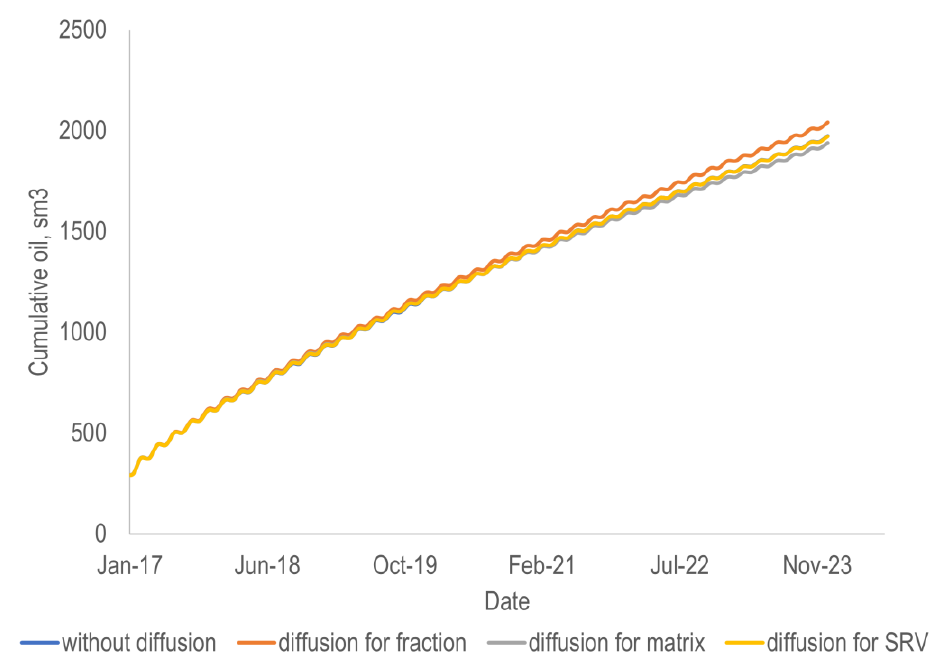
Figure 11. Cumulative oil production for diffusion coefficients for the fracture zones, SRV, matrix and without diffusion.